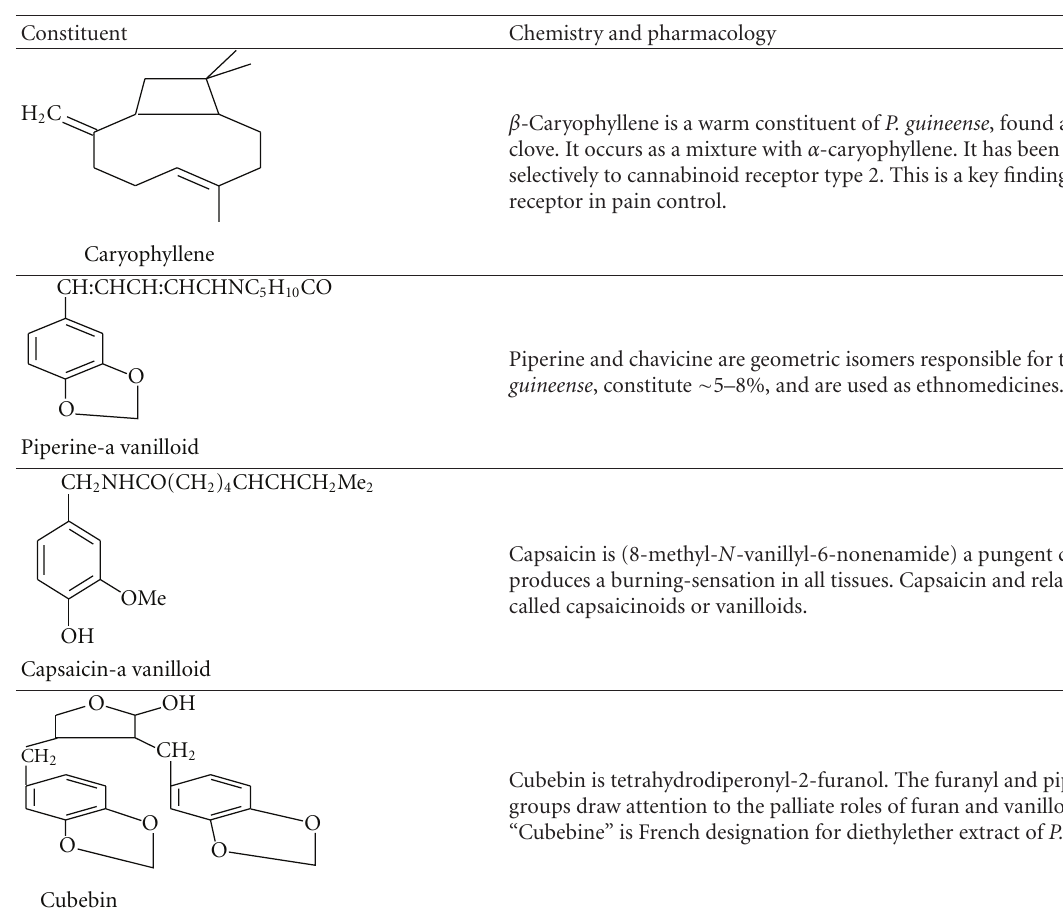
Table 3: Some bioactive agents of P. guineense and E. caryophyllata —components of